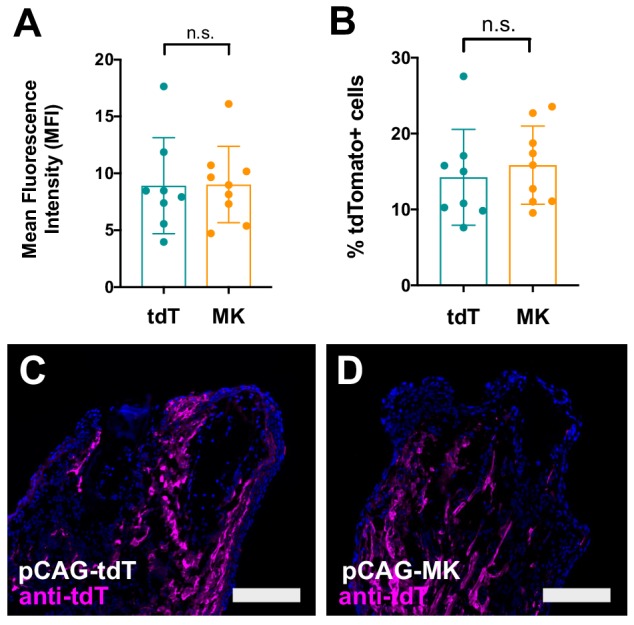
Electroporation efficiencies of pCAG-tdT and pCAG-MK injected regenerating limbs are similar.(A–B) Quantification of mean fluorescence intensity (MFI) (A) and the percentage of tdTomato+ cells out of the total DAPI+ cells (B) in the distal most 500 µm of regenerating pCAG-tdT (N = 8) and/or pCAG-MK (N = 9) electroporated limbs at 6 dpa. (C–D) Representative immunostaining against tdTomato of tdTomato- or MK-electroporated limbs. Two-tailed unpaired t-tests were performed for statistical analysis. Scale bar, 250 µm. dpa, days post-amputation, n.s., not significant.